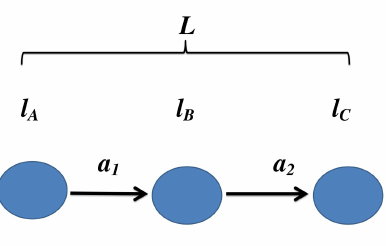
Figure 1. A Kripke frame ( left ) and an IBIS as its unraveling ( right ) [27].